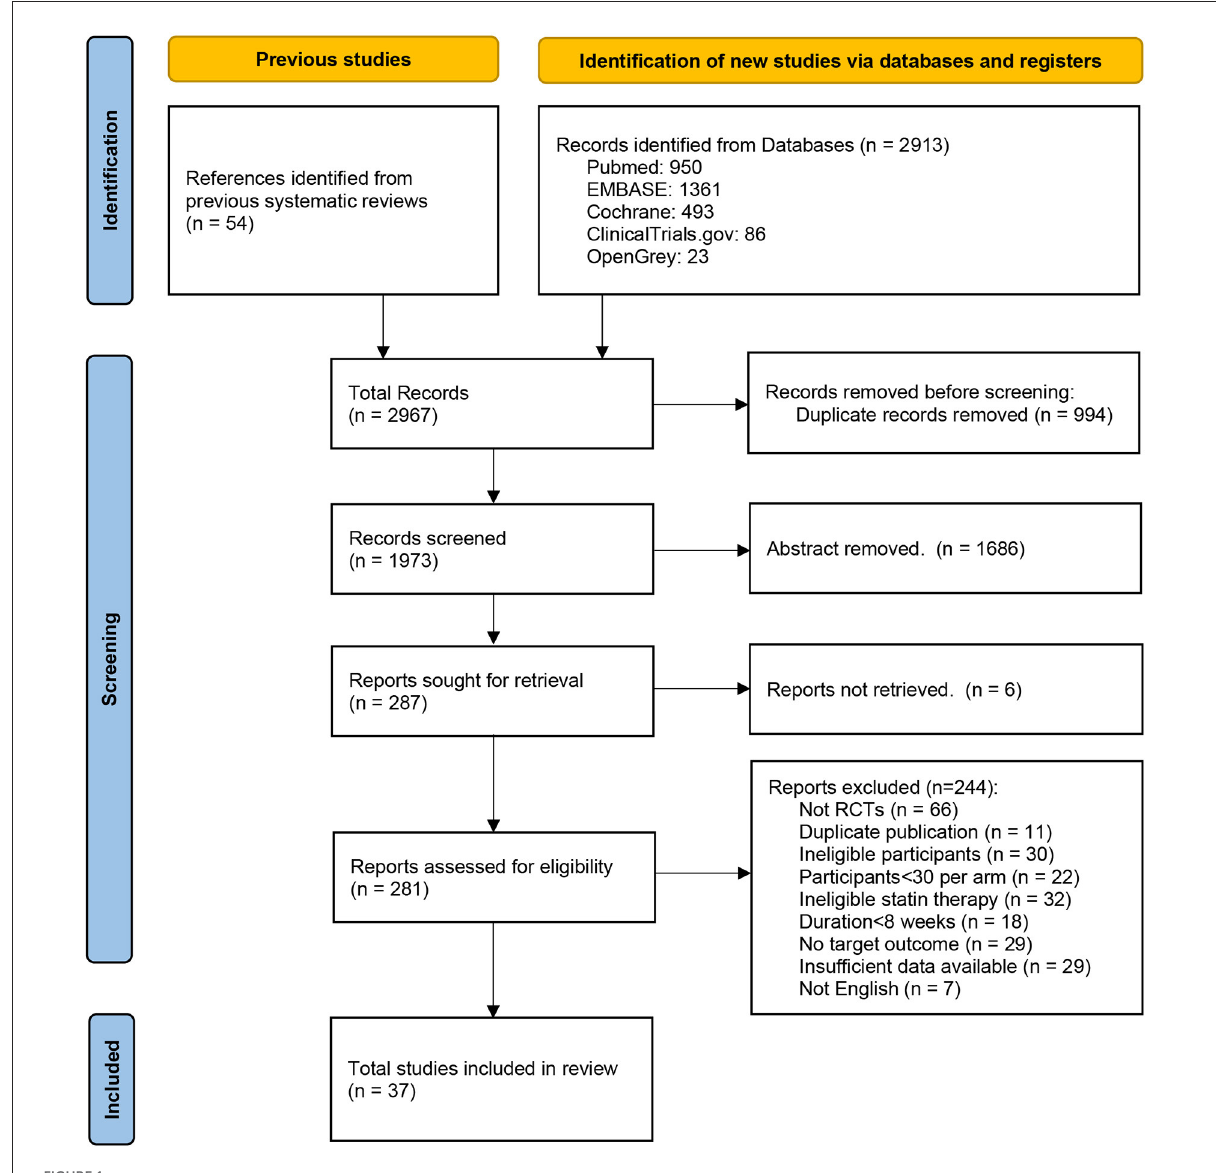
FIGURE1 Flow diagram of the study selection